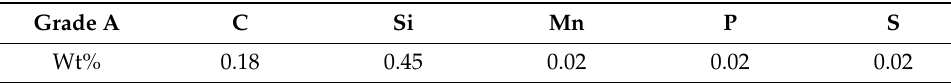
Table 1. Chemical composition of mild A-grade